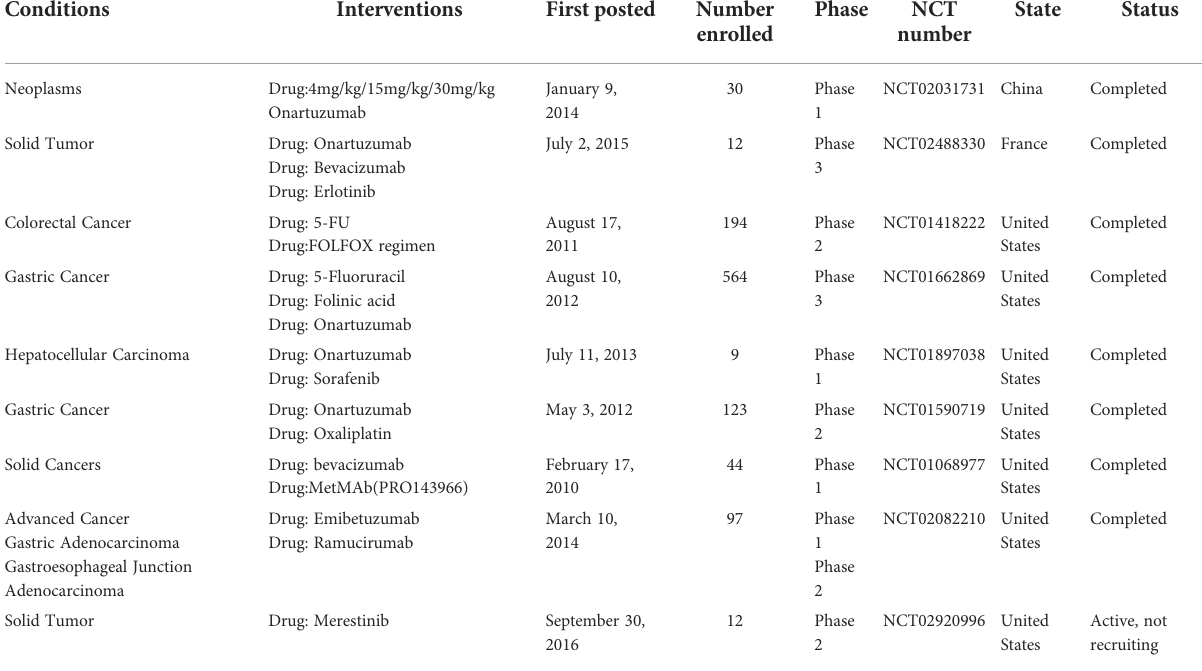
TABLE 2 Clinical studies on c-Met MAbs in the treatment of DSTs.